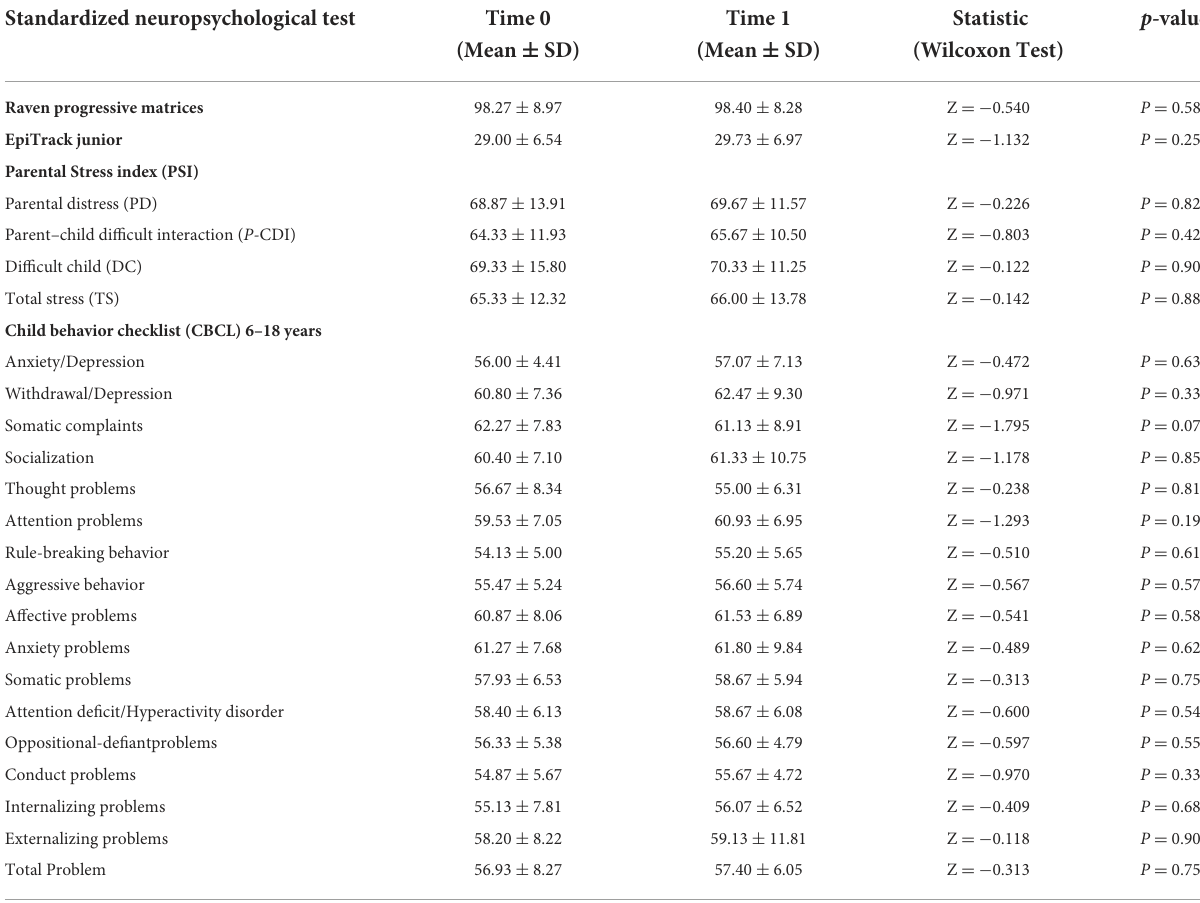
TABLE 2 Statistical comparison of mean neuropsychological scores (Raven’s Progressive Matrices, Epitrack Junior, Child Behavior CheckList, and Parental Stress) pre and after 6 months of PER add-on